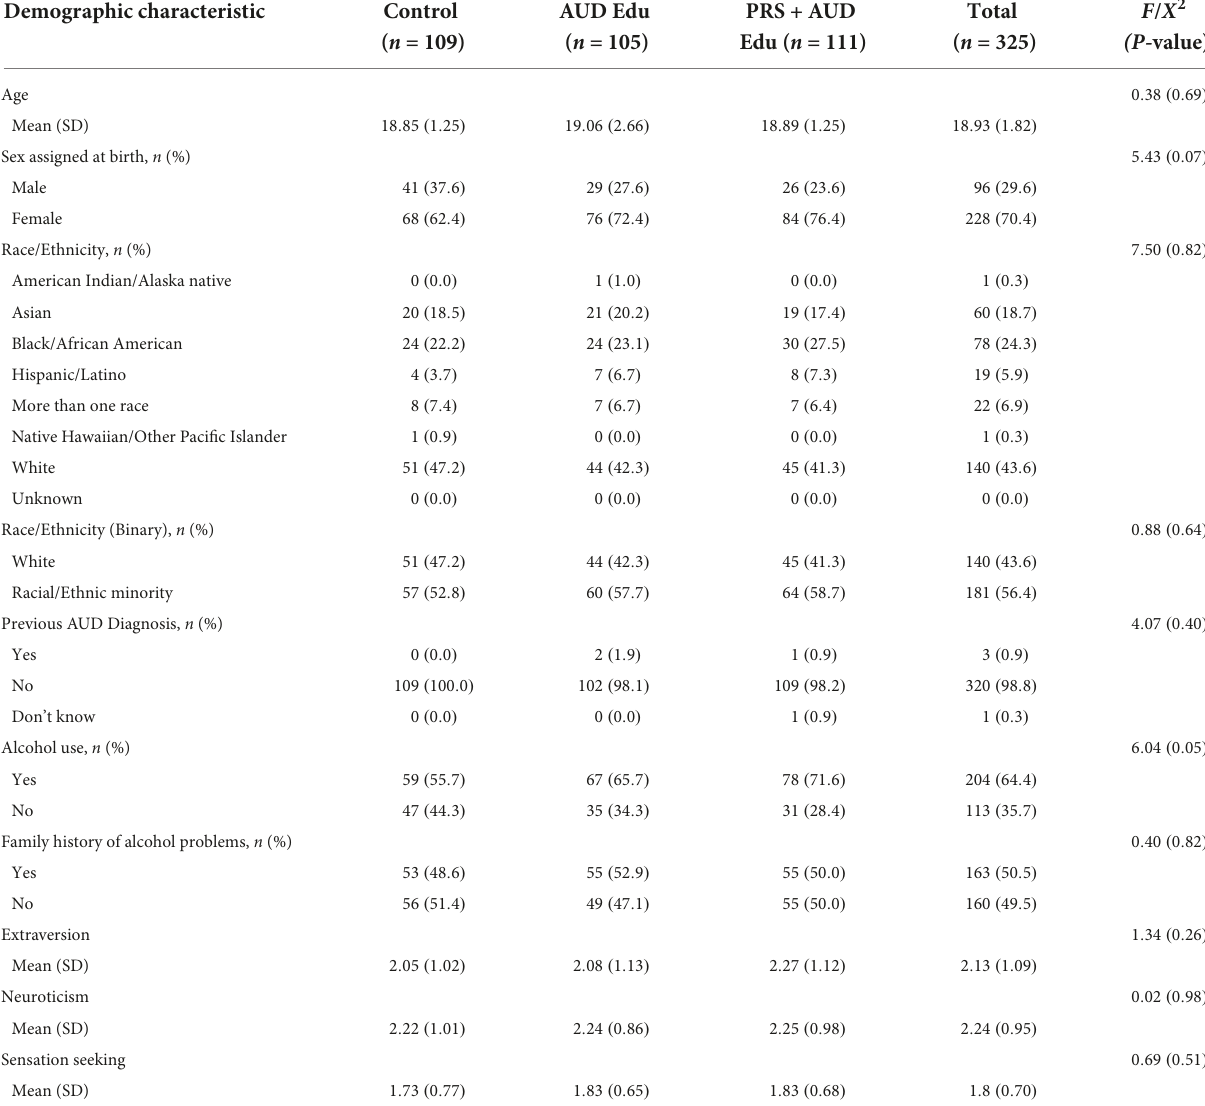
TABLE 1 Demographic characteristics for participants in each condition of the randomized controlled trial and for the total sample. Demographic